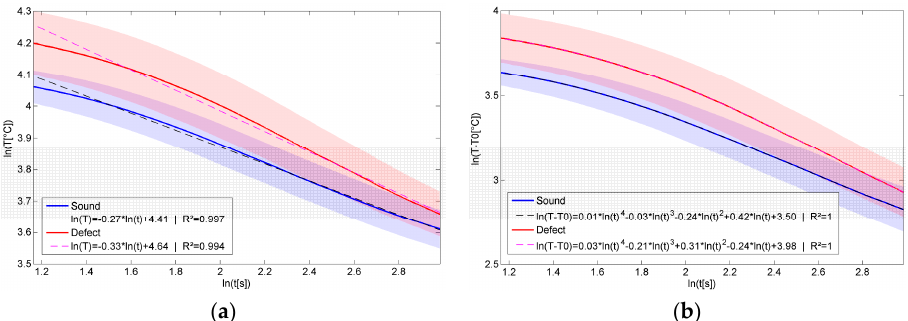
Figure 3. Mean cooling profiles of all sound (= clean) and defect (= contaminated) pixels of Sample 28. The shaded regions represent one standard deviation. The first order fit is illustrated in ( a ); and the thermal signal reconstruction using a fourth order fit is illustrated in ( b ).